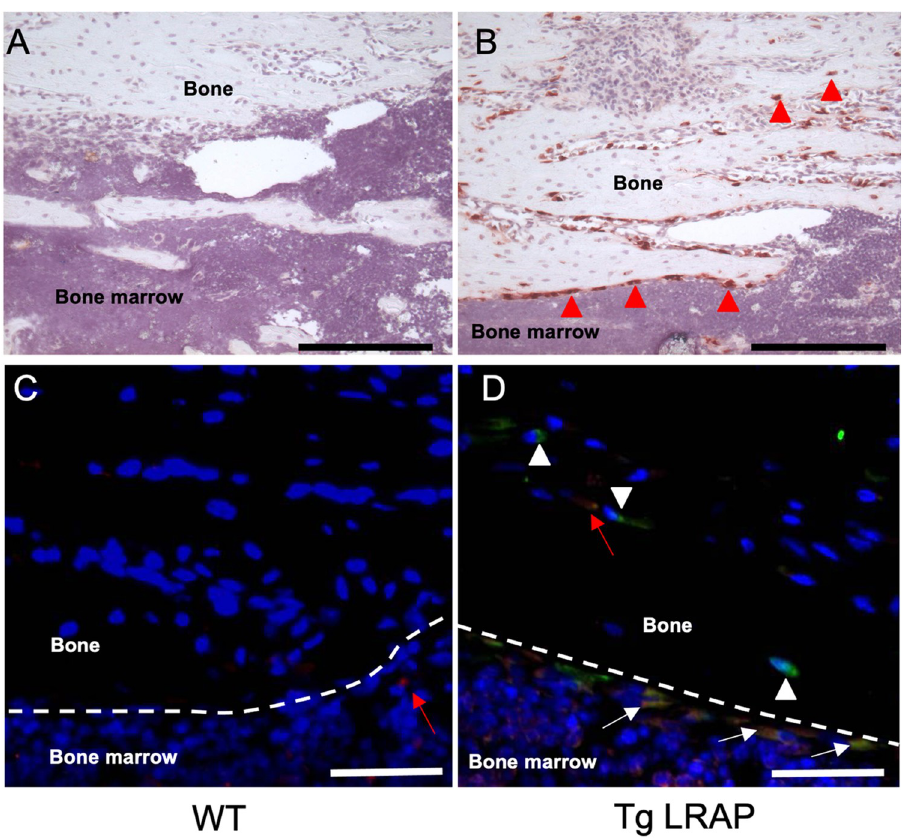
Fig 2. Expression pattern of the transgenes by immunohistochemistry. Transgene expression examined by immunohistochemistry using 1-month-old tibia tissue sections. A , No background signal was detected by anti-GFP antibody in wild-type mice. B , Intense signal from the anti-GFP antibody was detected in both the osteoblasts and osteocyte-like cells (red arrow heads) located in the bone matrix. C-D, Immunofluorescence staining to examine co- localization of LRAP and EGFP in tibia sections. Very faint signals were detected from WT tissue by the anti- amelogenin antibody ( C , red arrow). EGFP (green) and LRAP (red) were co-expressed in most of the osteoblast like cells in TgLRAP ( D , yellow cells indicated by white arrows). Cells that appeared to be osteocytes showed only the EGFP signal, suggesting the LRAP might be quickly degraded compared to EGFP in some cells (white arrow heads). On the other hand, endogenous amelogenin was detected in osteocyte-like cells located in the bone matrix without EGFP signal (red arrow). Red; anti-amelogenin antibody, Green; anti-GFP antibody, Yellow; merged. Dashed lines: border between bone matrix and bone marrow, Black bars = 200 μ m, White bars = 50 μ m. WT; wild-type mouse, TgLRAP; LRAP transgenic